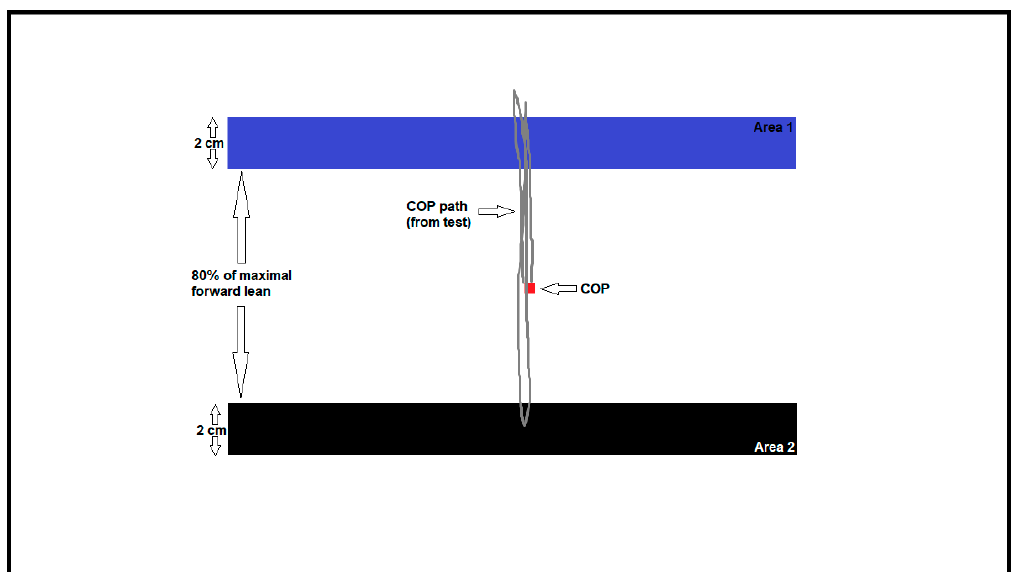
Figure 3. Phases representing subject’s COP excursion with regression lines during a limit of stability test.